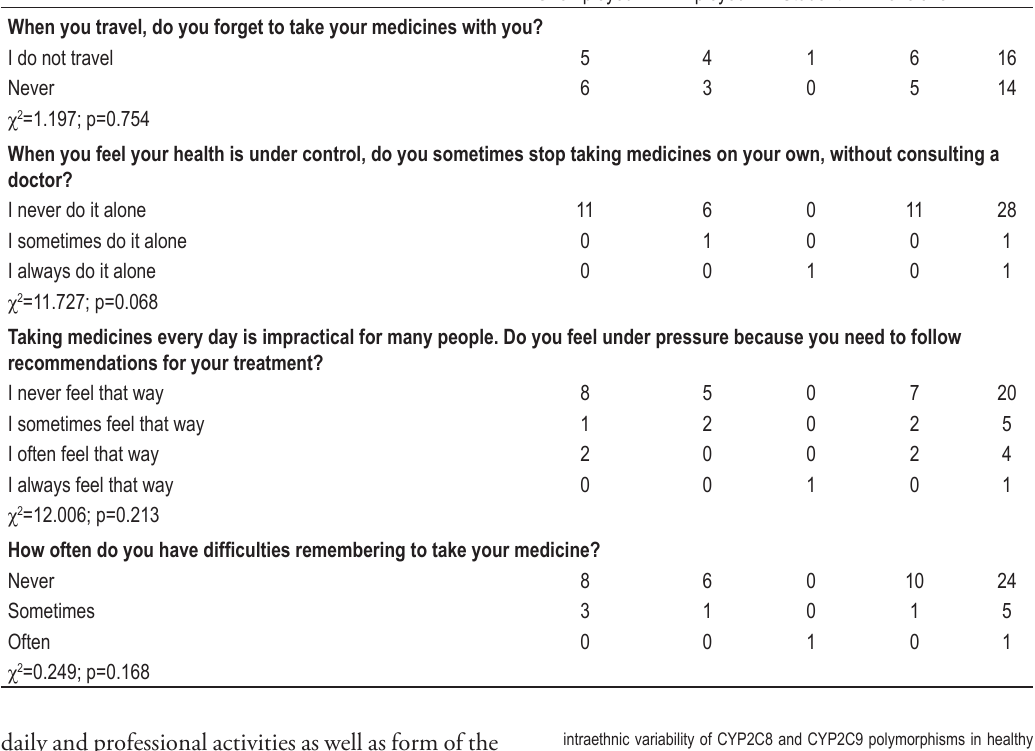
Employment status Total Unemployed